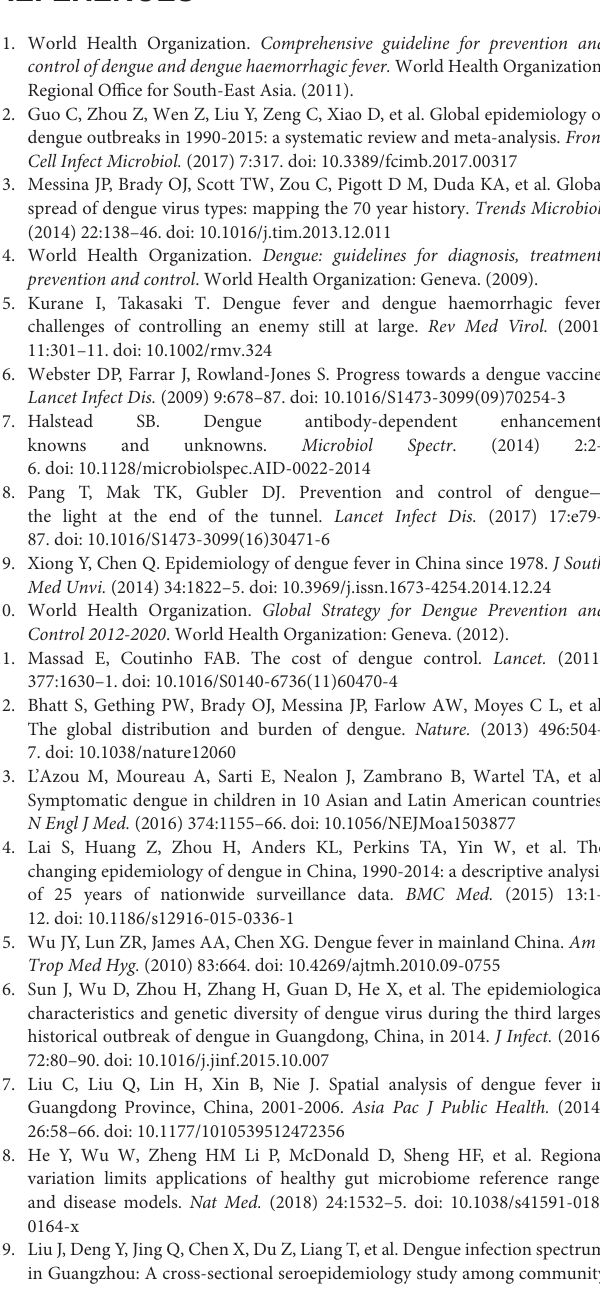
Supplementary Figure 7 | Bayesian evolutionary tree of DENV 3. Source countries/regions of each strain and different genotypes of DENV 3 are presented by colors. Red dots represent imported cases, blue dots represent local cases, and brown dots are internal branch points with posterior probability = 1.0. Supplementary Figure 8 | Bayesian evolutionary tree of DENV 4. Source countries/regions of each strain and different genotypes of DENV 4 are presented by colors. Red dots represent imported cases, blue dots represent local cases, and brown dots are internal branch points with posterior probability =